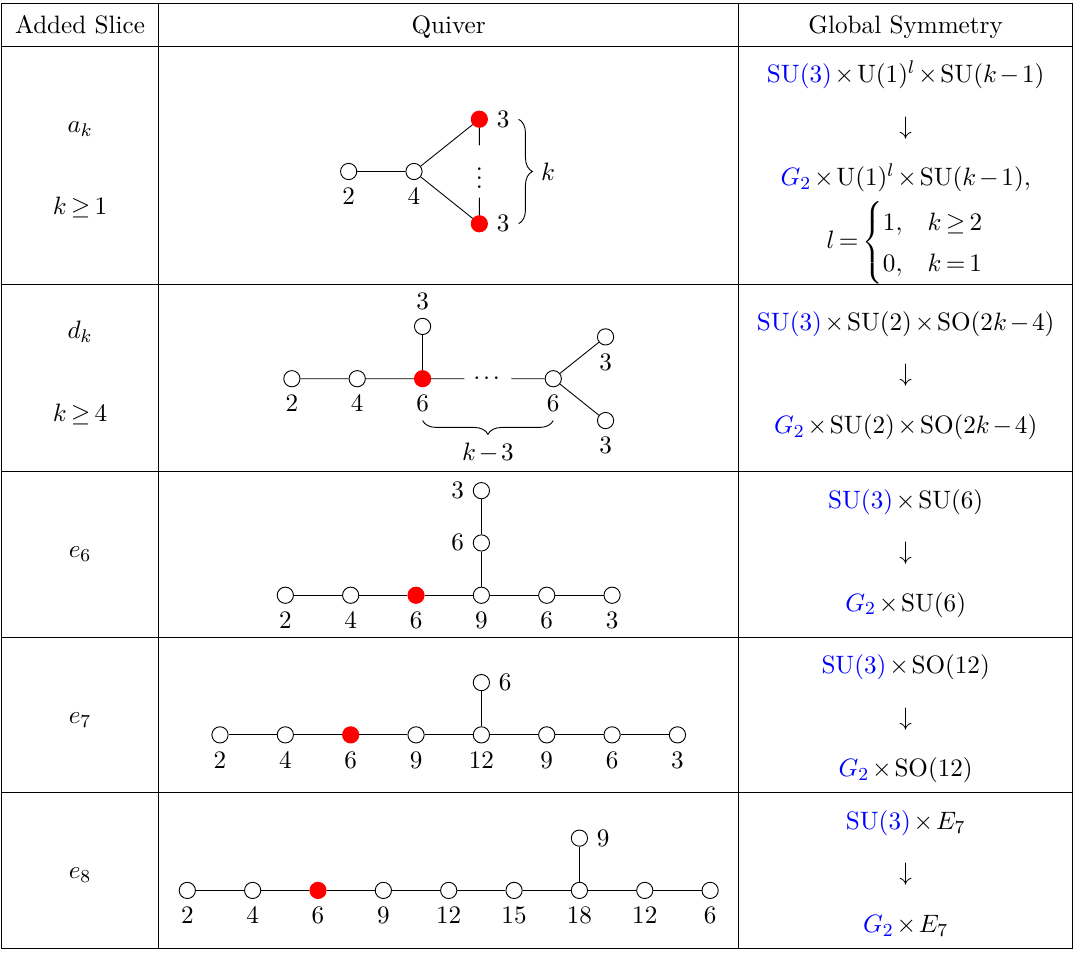
Table 12 . Quivers resulting from adding all possible simply laced elementary slices to the existing nodes of sub-regular G (5.1) to absorb a 2